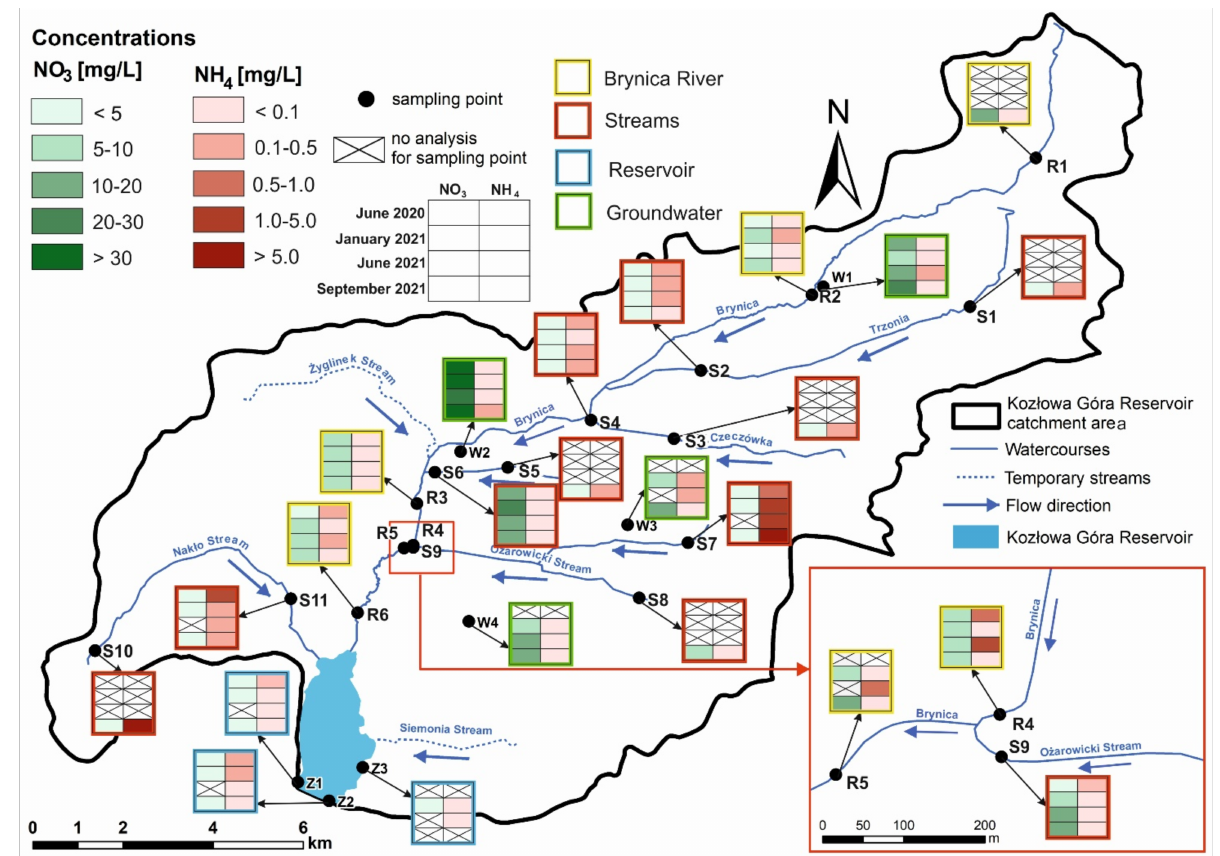
Figure 7. Variations in NO 3 − and NH 4+ concentrations within the study